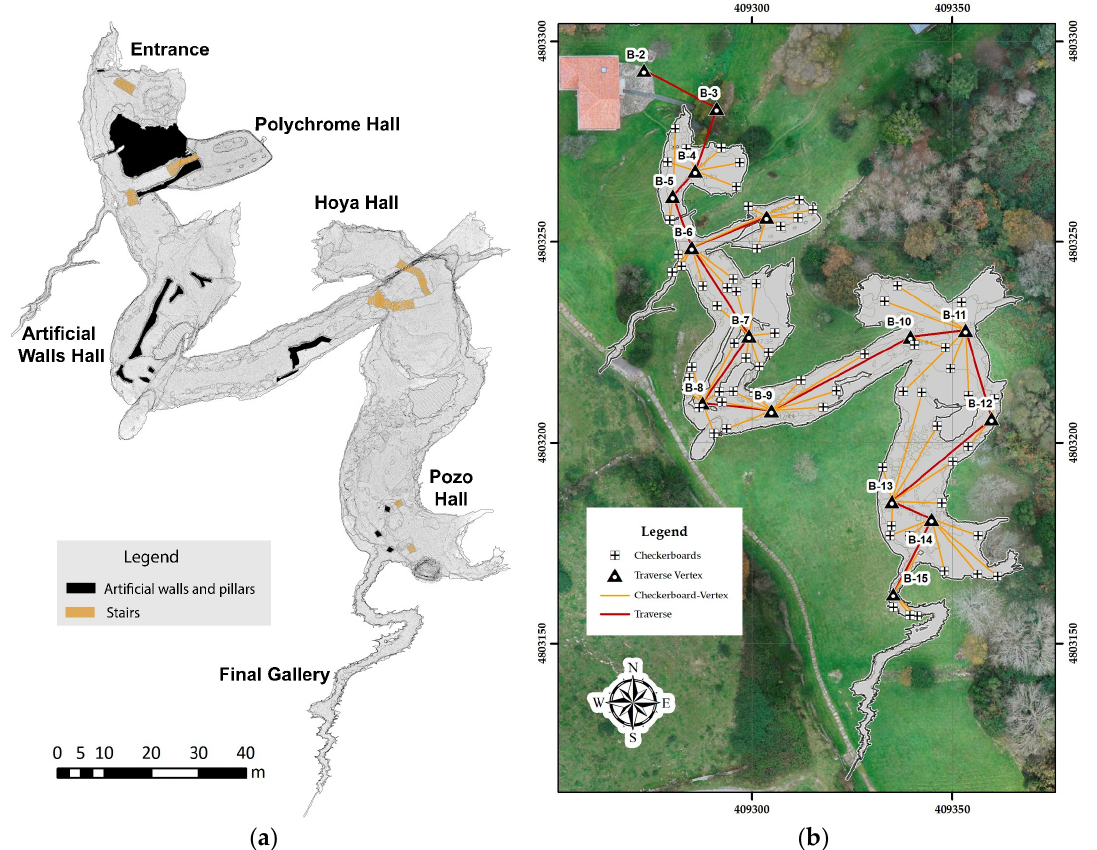
Figure 2. ( a ) Map of the interior of the Cave including gallery names, artificial walls, pillars, and stairs. ( b ) Map of the traverse and reference checkerboards, including the traverse station from which they